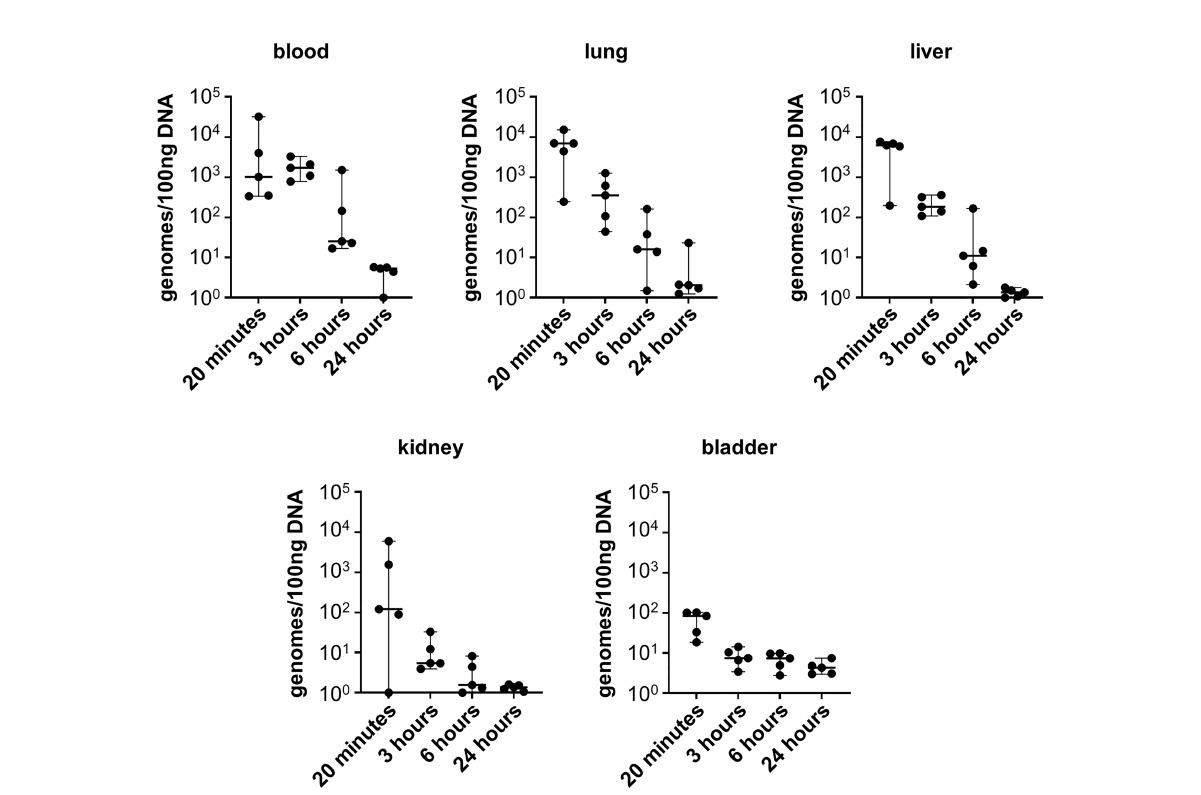
FIGURE 2 Non-pathogenic Leptospira is detectible for at least six hours post infection. Mice were inoculated intravenously and euthanized at various time points post-infection. DNA from tissues was harvested and quanti fi ed by qPCR. DNA was detected in signi fi cant quantities up to six hours post infection, and in some organs for twenty-four hours post infection. Data represent a total of fi ve mice per group. Median ± range is